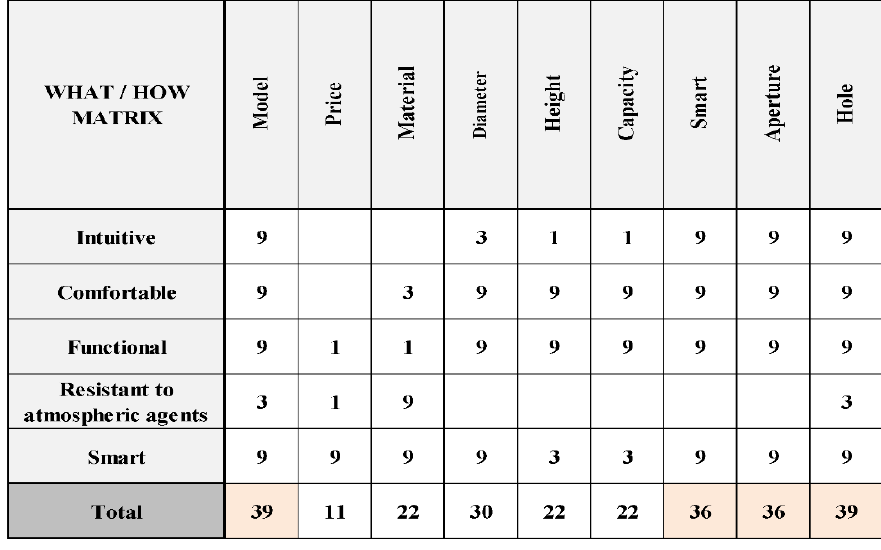
Figure 7. What/How Figure 7. What/How Matrix.